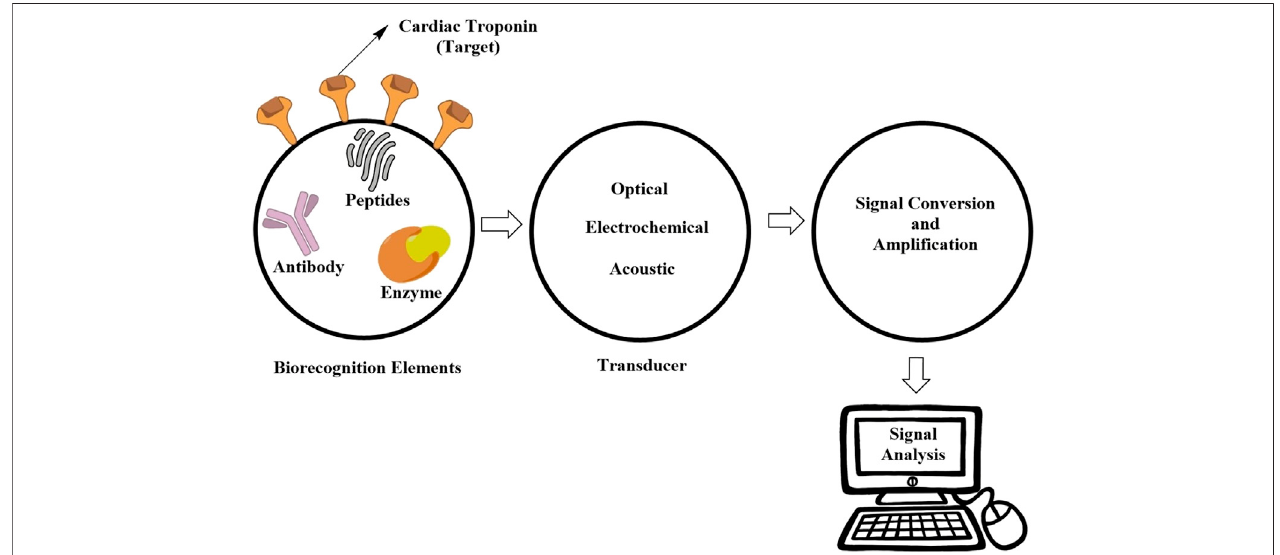
FIGURE 1 | Mechanisms underlying the primary function of